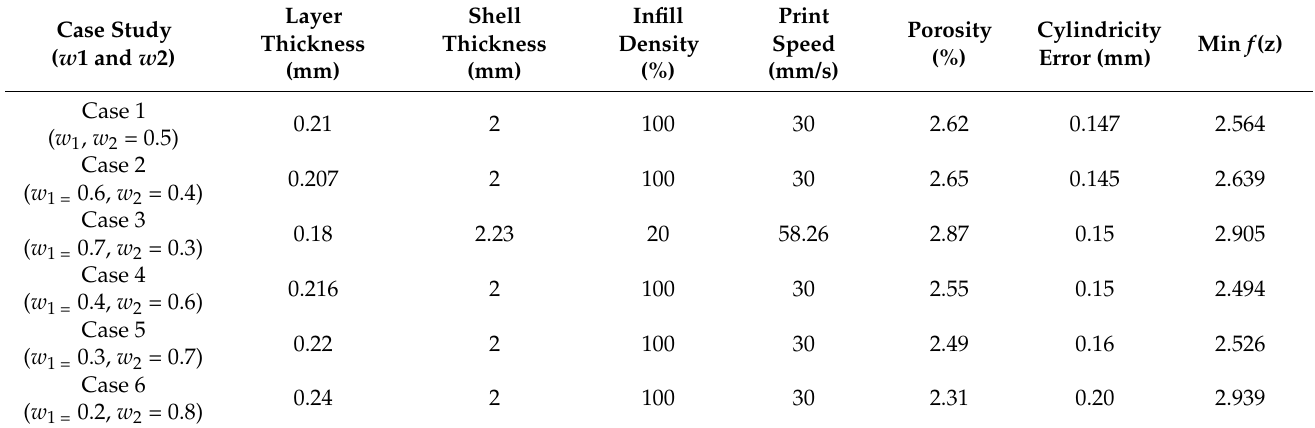
Table 5. Summary of results of the optimal fused deposition modeling